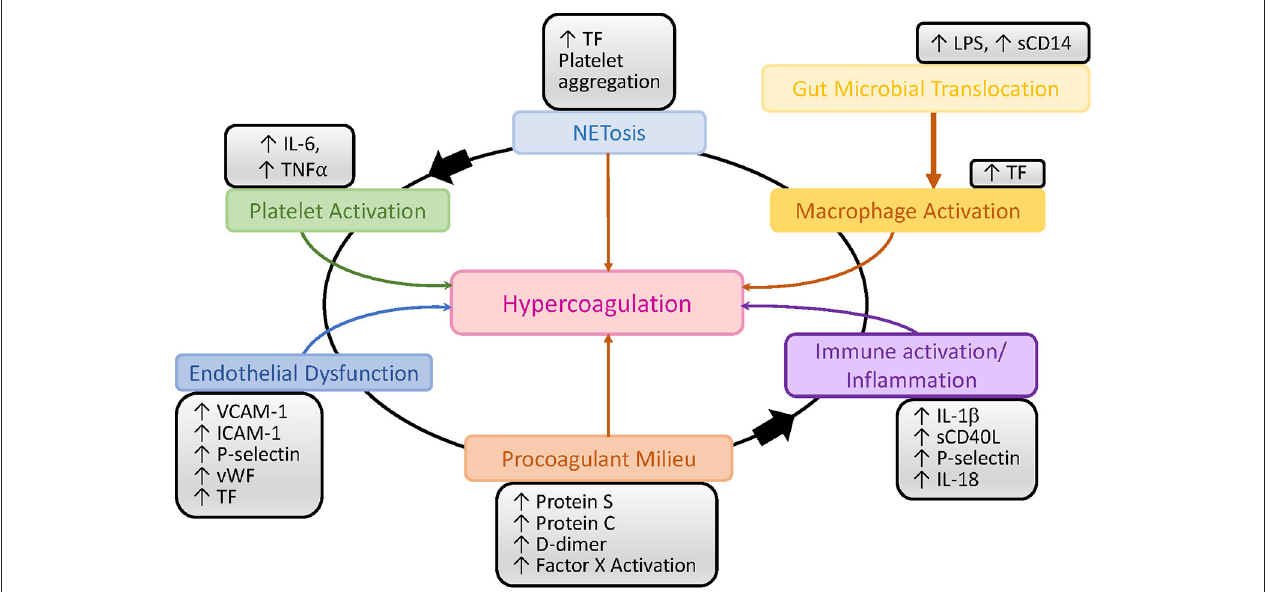
FIGURE 2 | Schematic representation of the interactions between inflammation, immune activation and the coagulation pathways in HIV/SIV infection. LPS, lipopolysaccharide; TF, tissue factor; vWF, von Willebrand factor.